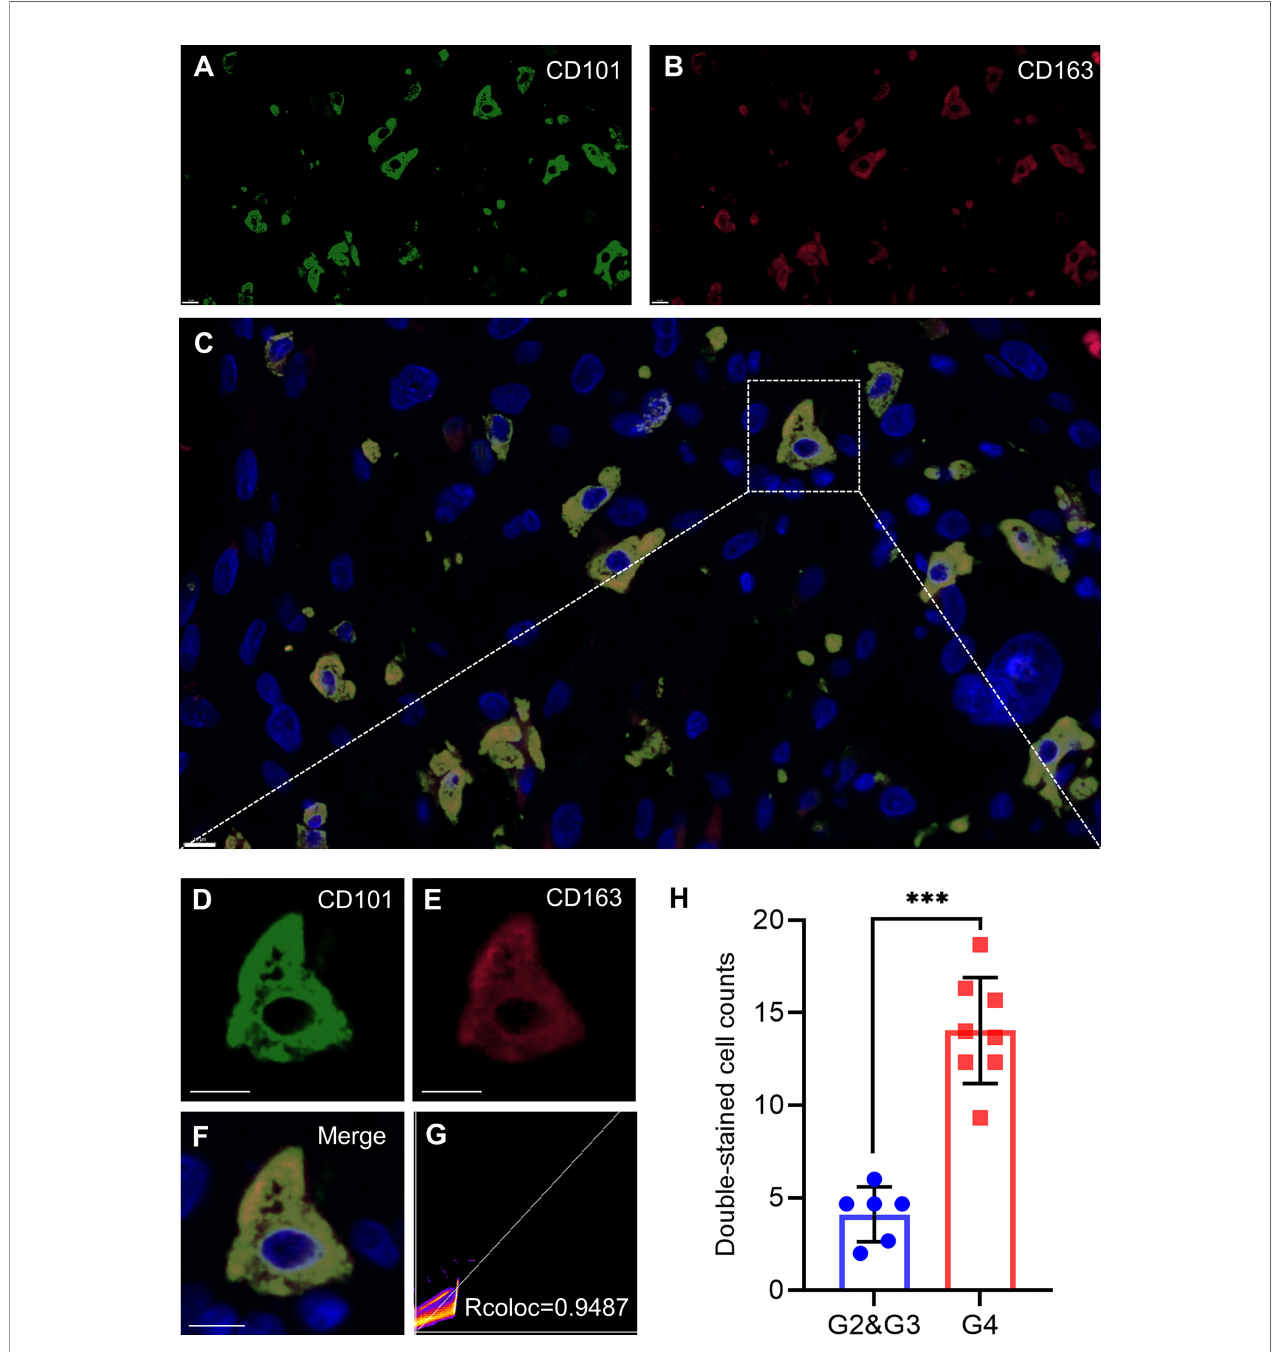
FIGURE 11 | CD101 is a new biomarker on TAMs. (A – H) Representative confocal fl uorescence microscopy image of CD101 (A, D) CD163 (B, E) , and merge (C, F) in GBM tissue from patients. DAPI (blue) was used for nuclear staining. Scale bar 10 m m. (G) Colocalization analysis between CD101 and CD163. (H) Double- stained cell counts in glioma with different grades. Statistical signi fi cance was determined using the T test. (*** p <